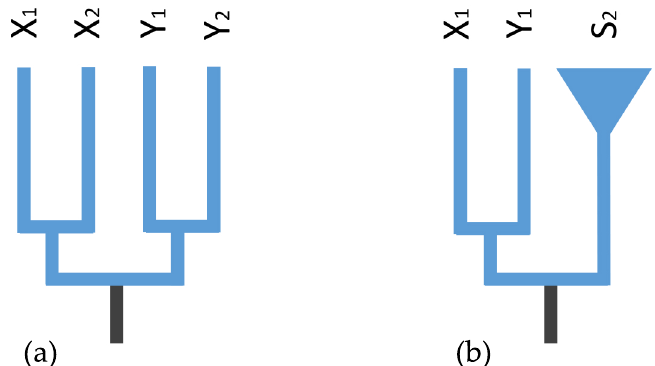
Figure 2. Gene genealogies under different evolutionary scenarios. ( a ) The marker is on the ancestral sex-determining region of sex chromosomes and thus is sex-linked in two species, but due to the absence of X–Y recombination, alleles cluster according to gametologs, and not species. ( b ) The marker is on sex chromosomes but outside the ancestral sex-determining region and thus sex-linked in species one rather than species two, whose genealogies conform to species genealogy when X–Y recombination occurs in the